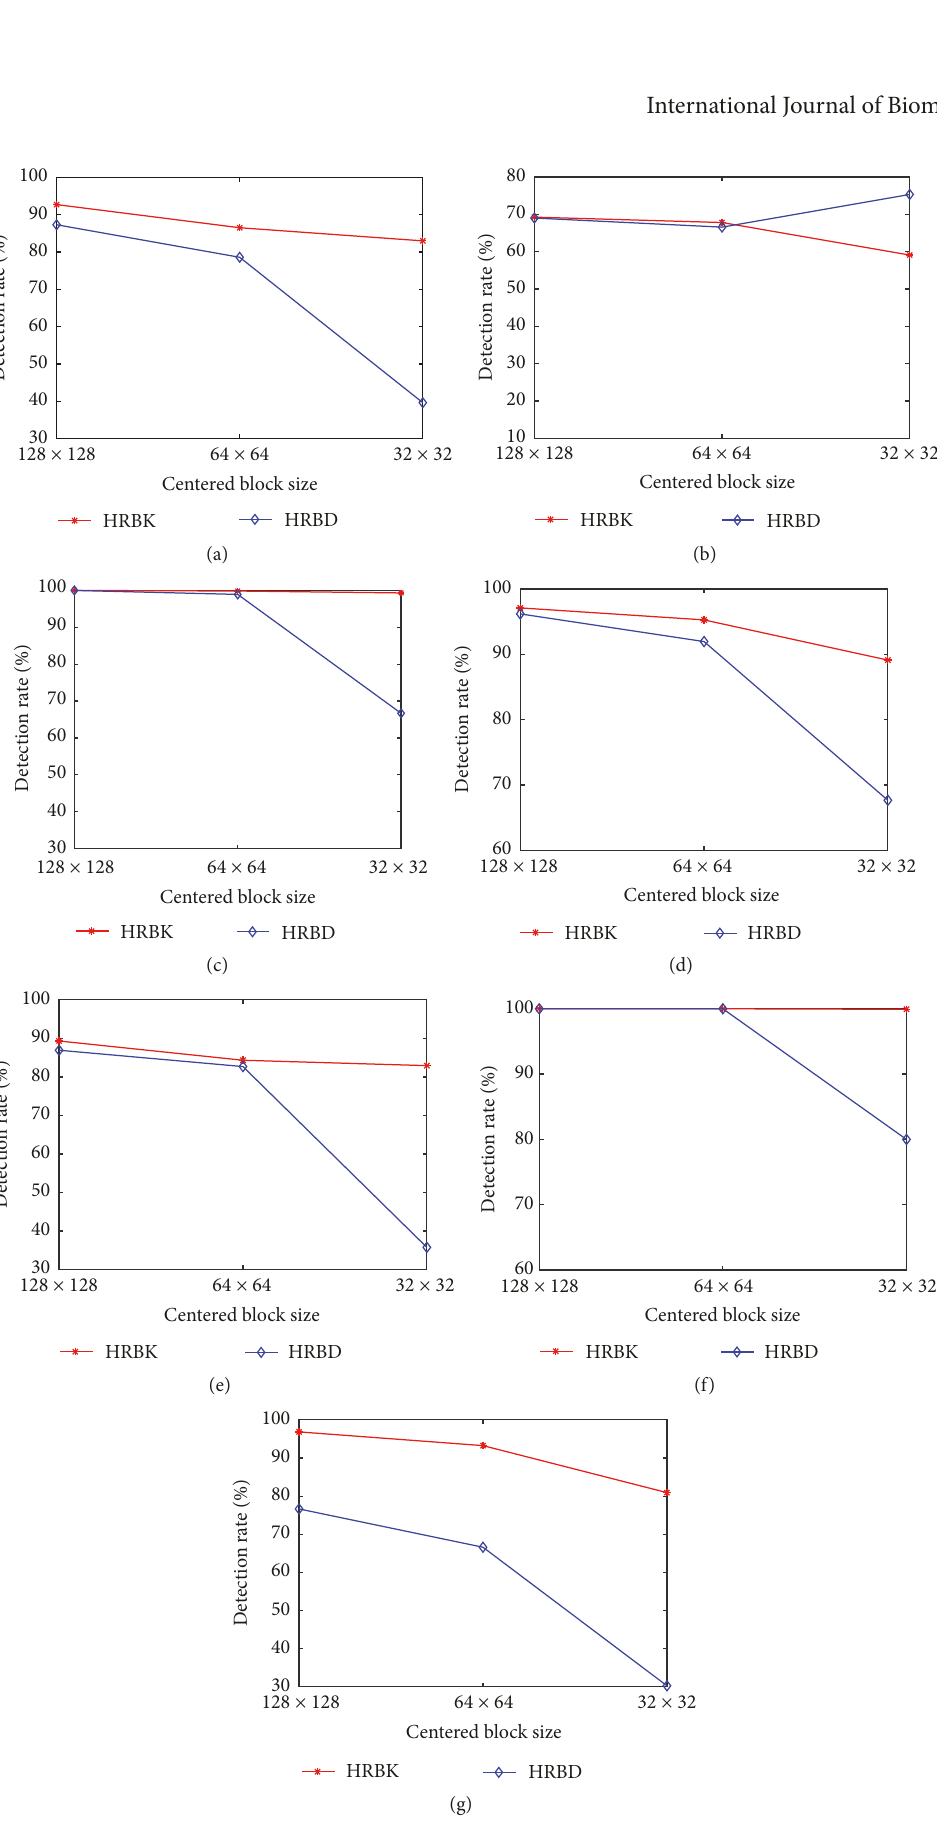
Figure 6: CT image modification detection rates for different centered block sizes and various modification types: (a) JPEG2000, (b) Gaussian filtering, (c) Laplacian filtering, (d) brightening, (e) scaling, (f) histogram equalization, (g) JPEG